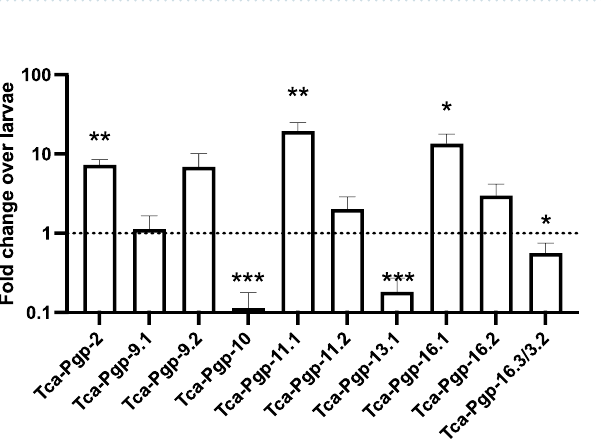
Table 1. Nomenclature for P-gp protein sequences in Toxocara canis.